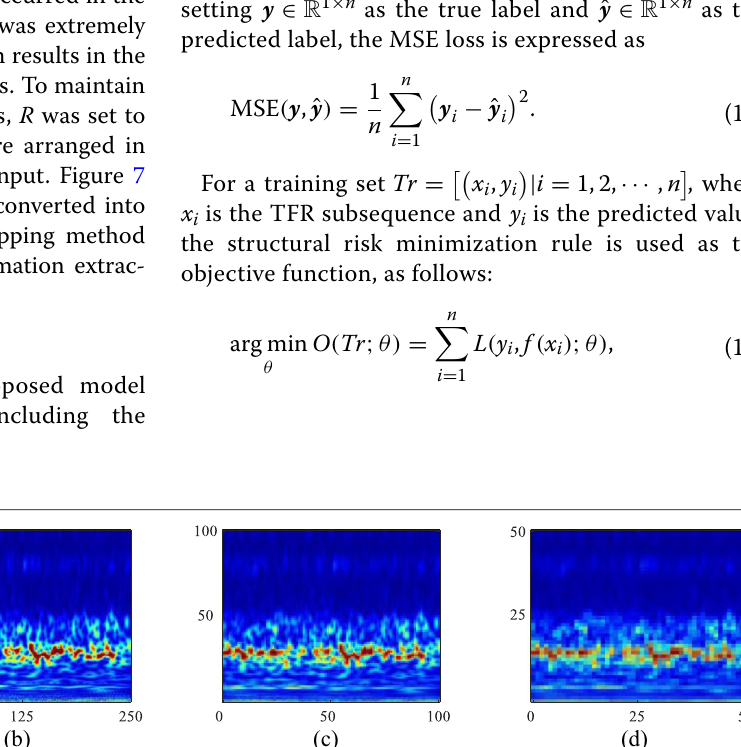
500; (b) R 250; (c) R 100; (d) R = = = =